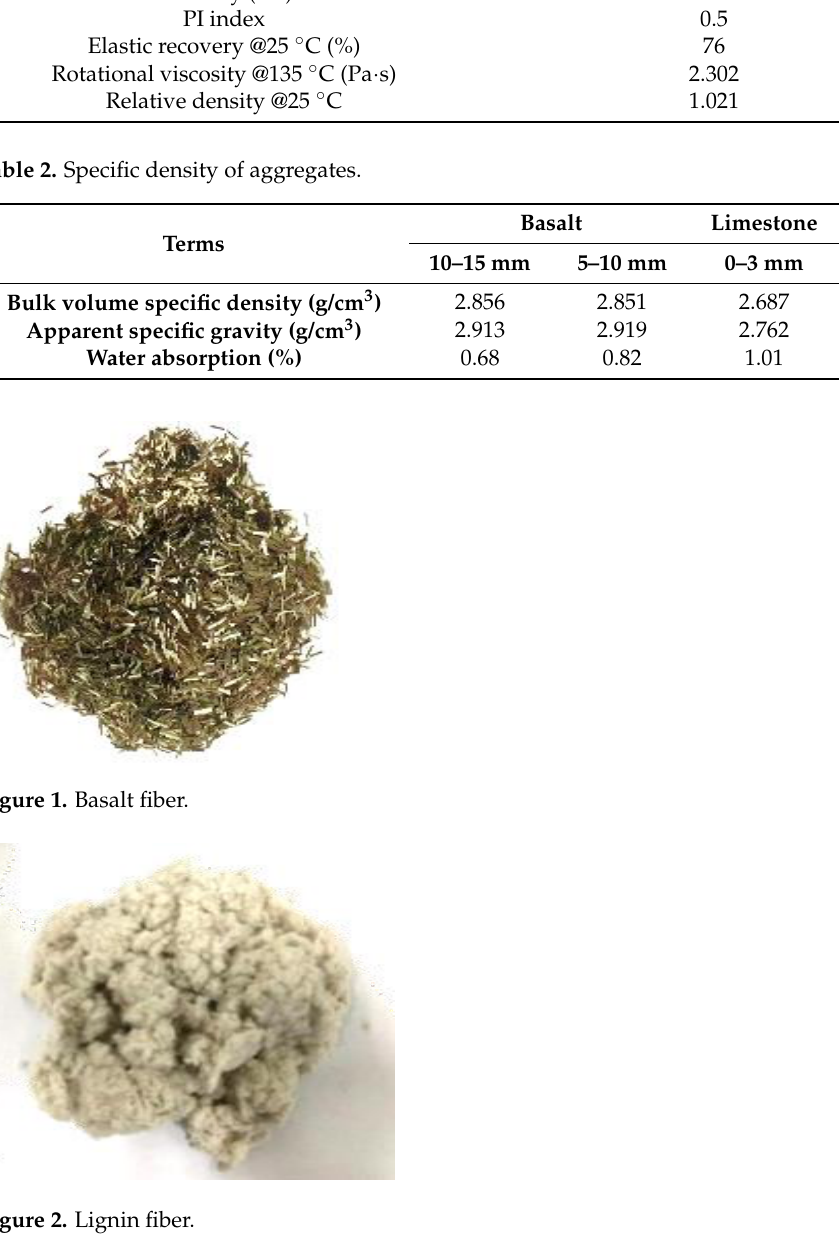
Table 2. Specific density of aggregates.